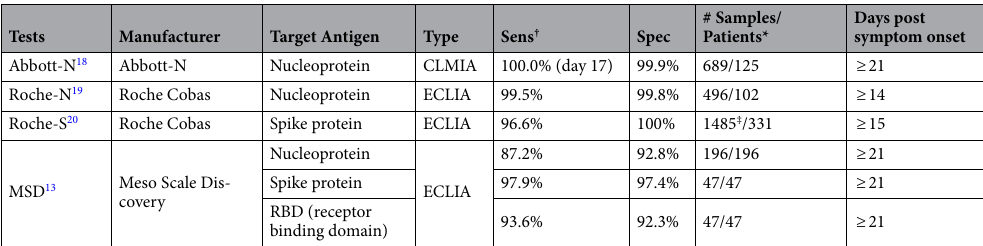
Table 1. A summary of the existing published data for the commercially available tests in this comparison. The corresponding antigen target and published sensitivity, specificity, positive predictive value and negative predictive value (if available). ECLIA Electro Chemiluminescent Immunoassay, CLMIA chemiluminescent microparticle immuno assay, PPV positive predictive value, NPV negative predictive value, Sens sensitivity, Spec specificity, ELISA enzyme linked immunosorbent assay. † The highest reported sensitivity. ‡ 233 of these samples were tested at ≥ 15 days post PCR diagnosis. *For sensitivity testing.